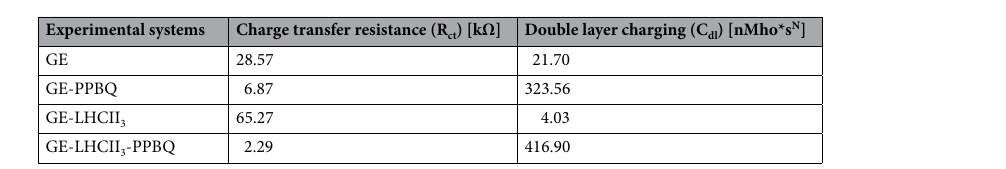
Table 2. Parameters obtained by fitting EIS spectra to an electrochemical model.